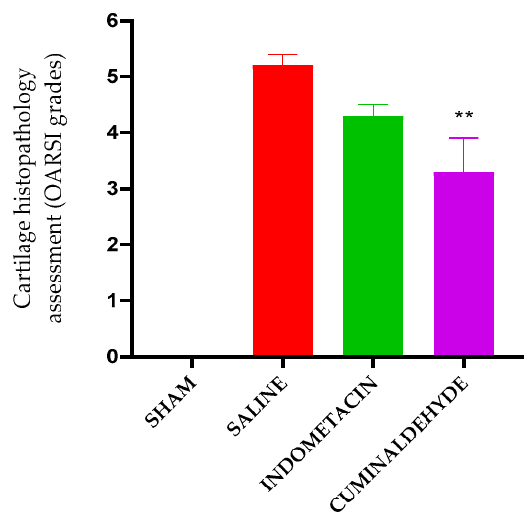
Figure 5. Results of histopathological cartilage evaluations, classified by the Osteoarthritis Research Society International (OARSI) scoring system. The analysis was performed on the knees collected on the 29th day after OA induction. The groups included the untreated and OA uninduced (SHAM), the induced OA and untreated group (CTL − ), the induced OA and Indomethacin-treated group, and the induced OA and Cuminaldehyde-treated group. The Y -axis represents the histopathological evaluation of cartilage according to the OARSI histological classification system: Grade 0—surface intact and cartilage intact; Grade 1—surface intact; Grade 2—surface discontinuity; Grade 3—vertical fissures; Grade 4—erosion; Grade 5—denudation; and Grade 6—deformation). ** Significant differences, at p < 0.005 compared to the saline group (CTL − ). (one-way ANOVA; Tukey).